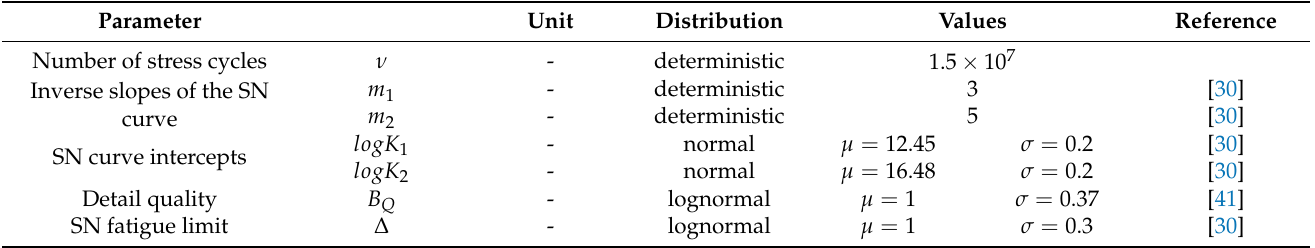
Table 4. Probabilistic and deterministic parameters for the calculation for the reliability index and the cumulative probability of failure.